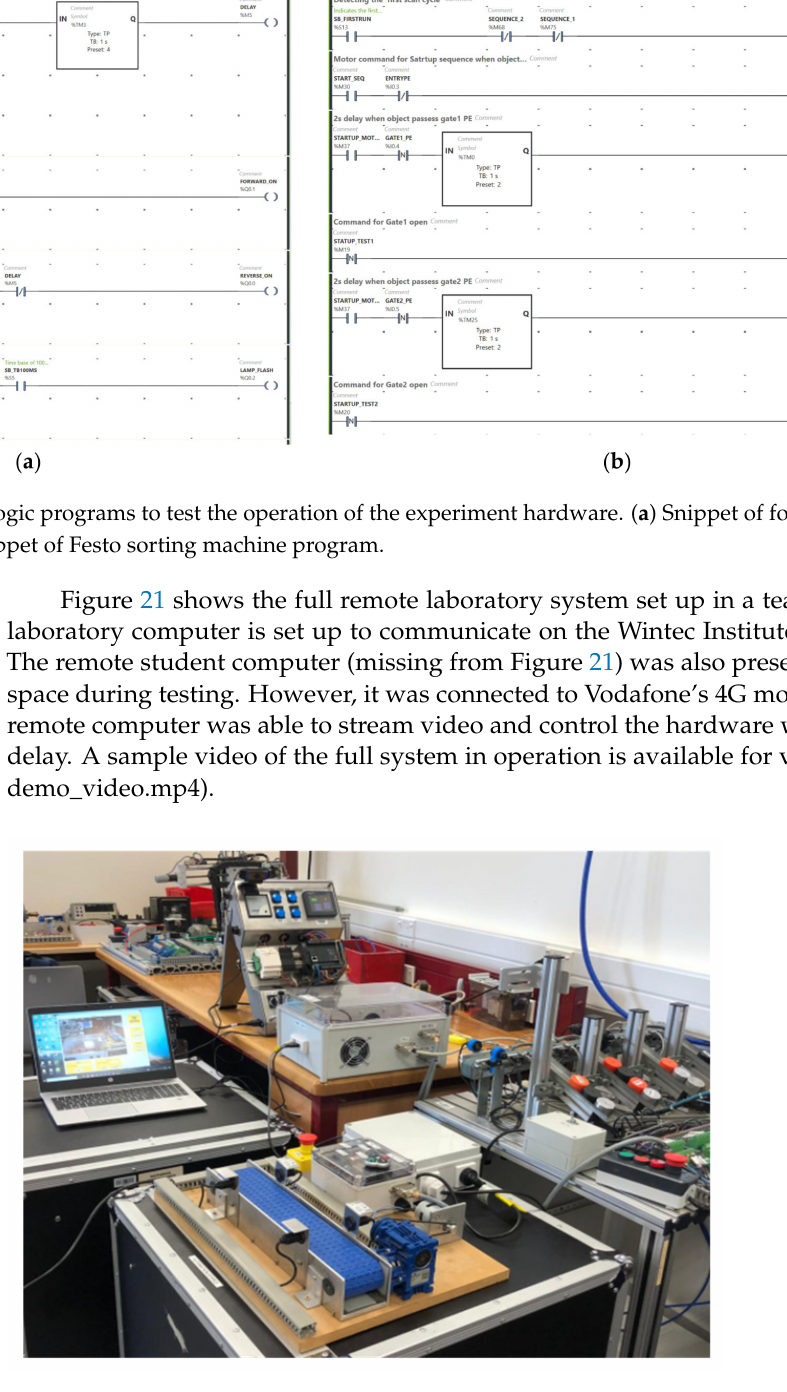
Figure 21. Complete remote laboratory system set